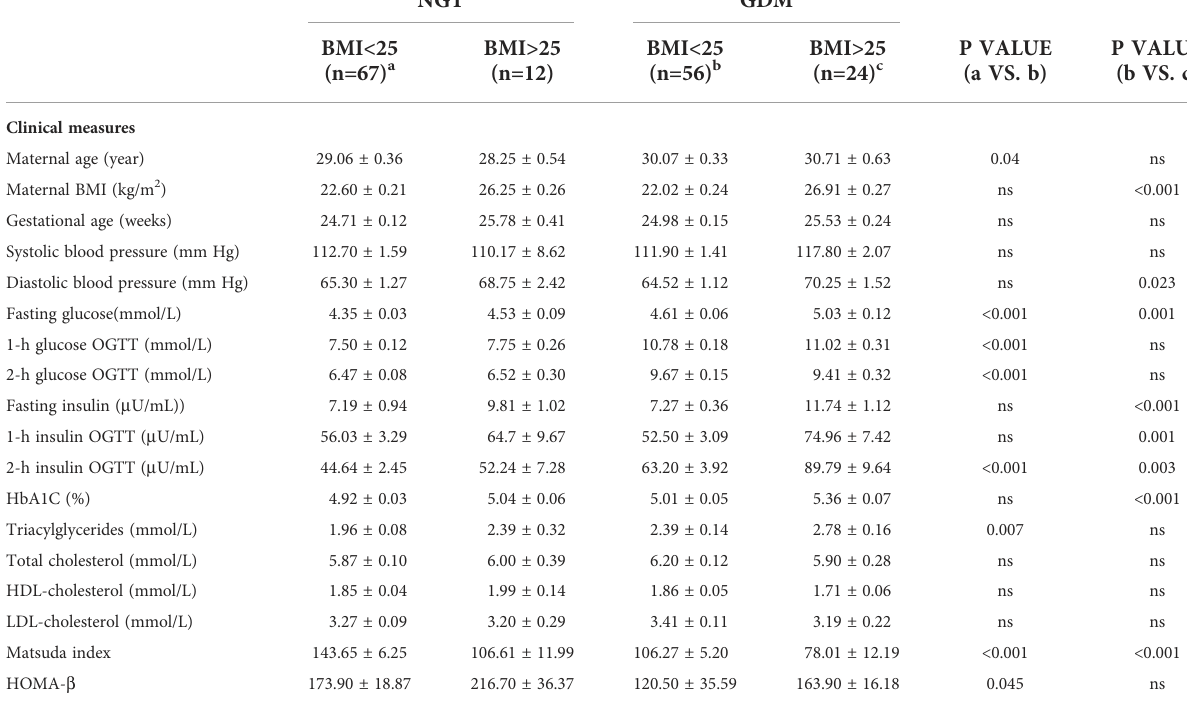
TABLE 4 Clinical characteristics of GDM group and NGT groups with different maternal